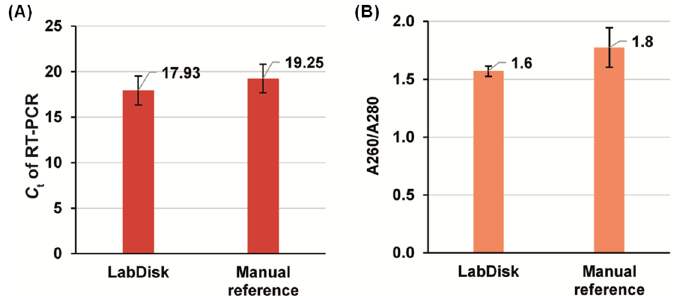
Figure 8. Results comparing the performance of the nucleic acid extraction using the LabDisk ( n = 4) and the manual reference method ( n = 3). ( A ): Ct values of RT ‐ PCR on RPS7 gene (PCR on all eluates, derived from both the LabDisk and manual extraction, were performed in tube). ( B ): Spectrophotometric determination of eluate purity by means of protein contamination assessment.